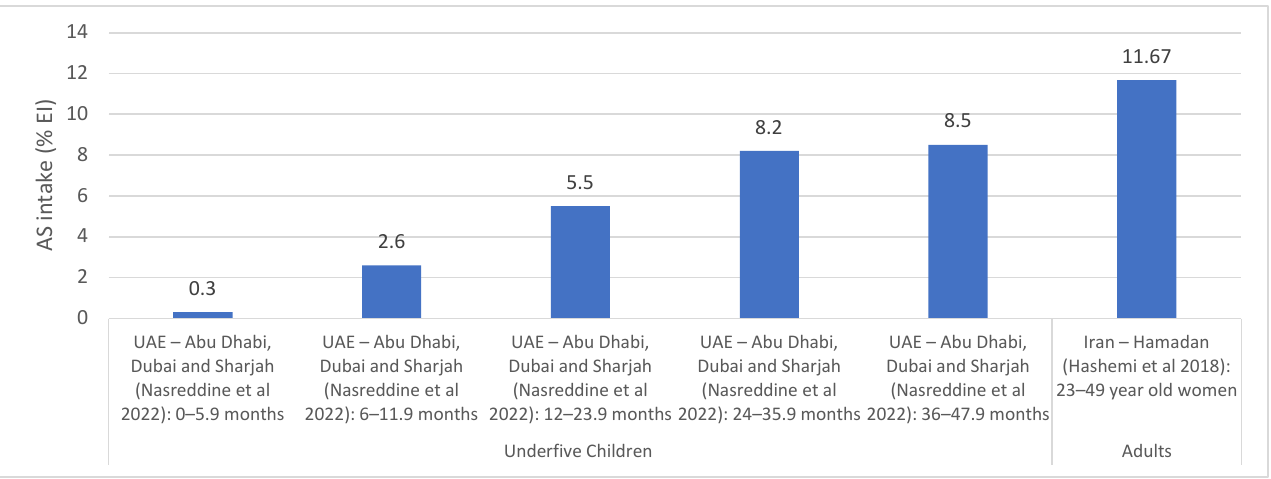
Figure 4. AS intake estimates (% EI) based on regional studies in countries of the EMR. Abbrevia- tions: AS: added sugars; EI: energy intake; EMR: Eastern Mediterranean Region; UAE: United Arab